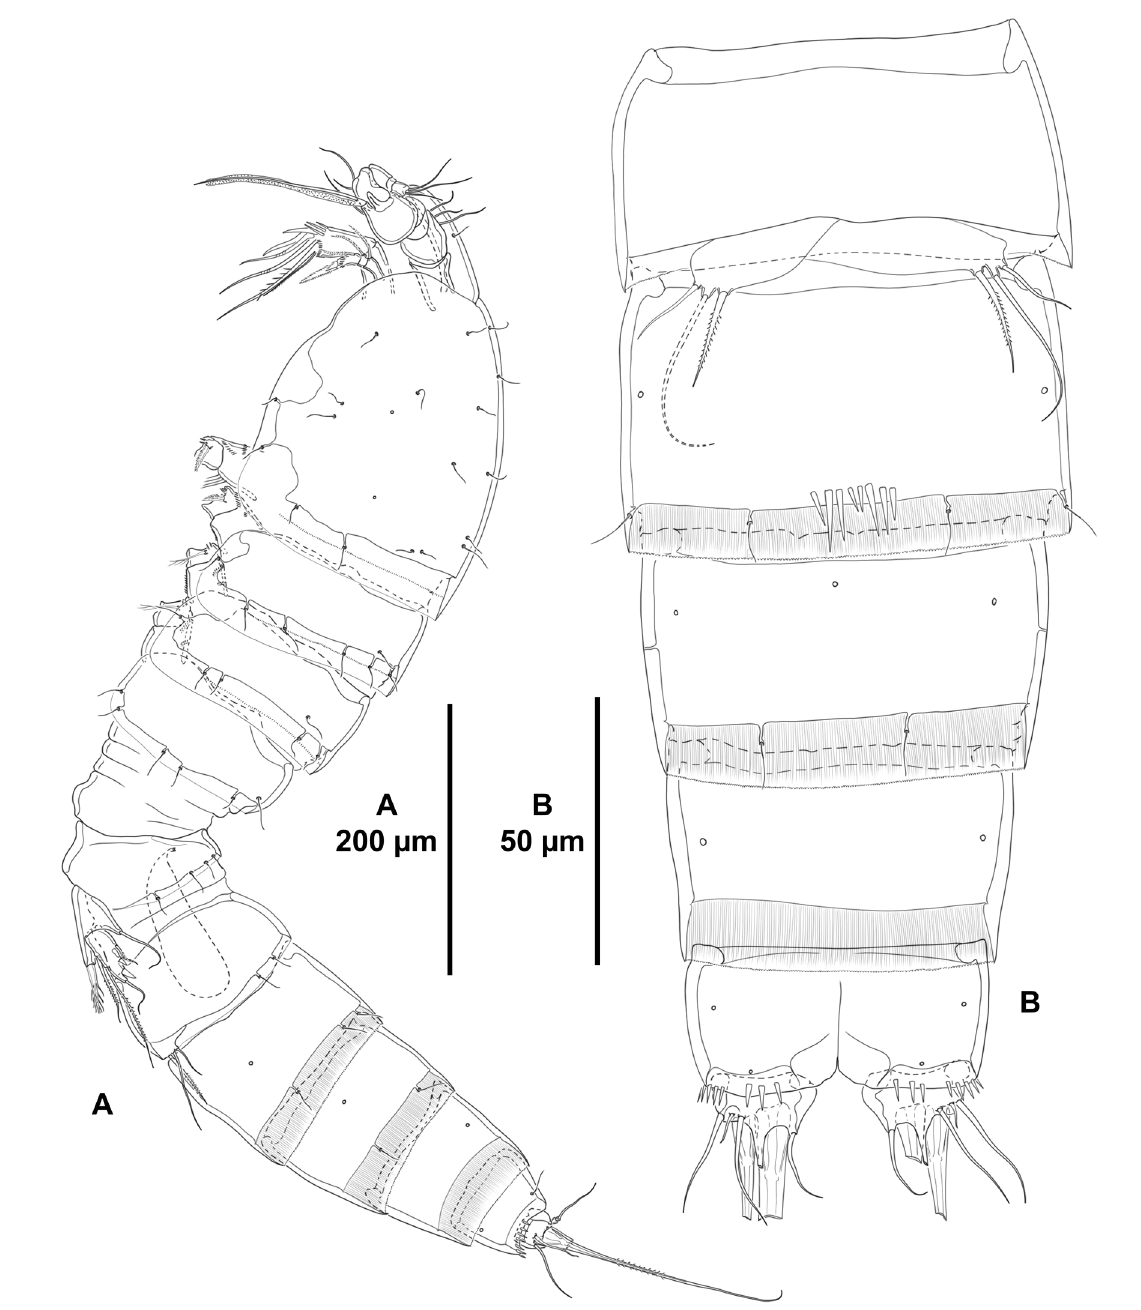
Fig. 17. Spinodiosaccus primus gen. et sp. nov. A . Allotype, ♂ (ICML-EMUCOP-180119-58); habitus, lateral view. B . Paratype, ♂ (ICML-EMUCOP-180119-67); urosome, ventral view (P5-bearing somite